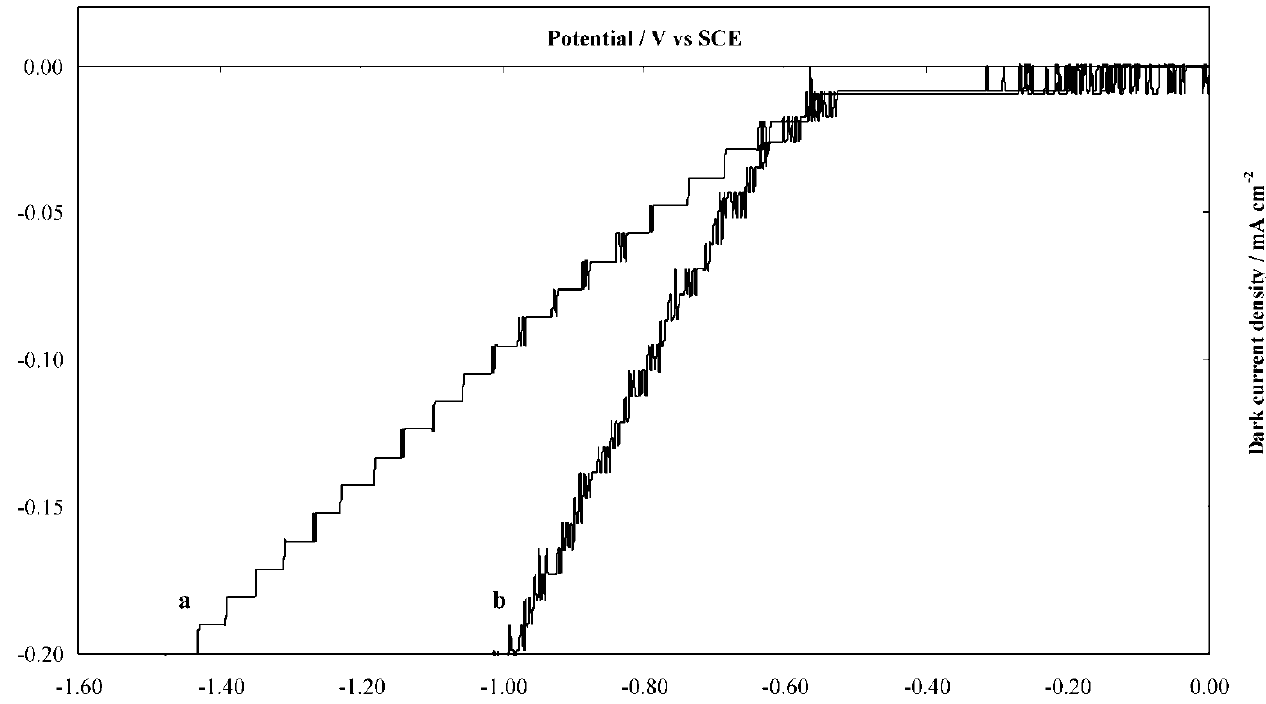
FIGURE 5 Dark J – V plots of (a) slowly cooled and (b) quenched n -Si from 600 (cid:1) C. All J – V measurements were conducted in water = LiClO 4 = K 4 [Fe(CN) 6 ] = K 3 [Fe(CN) 6 ] at 25 (cid:1) C.